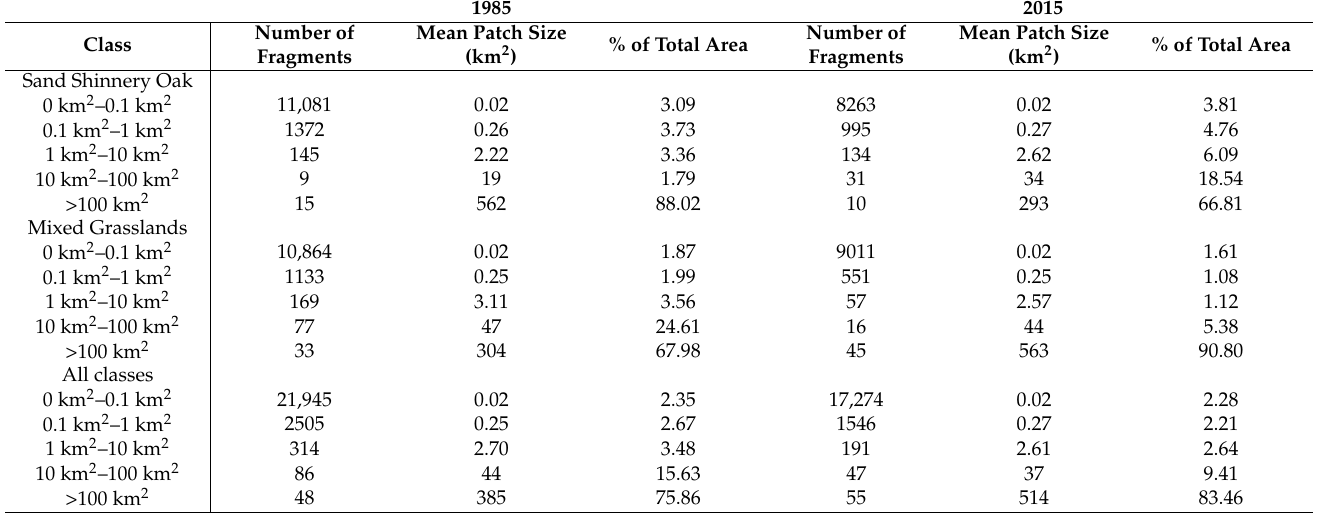
Table 3. Summary of the fragmentation statistics from the 1985–2015 Landsat-based assessment to map vegetation communities that support lesser prairie-chicken populations on the New Mexico and Texas Southern High